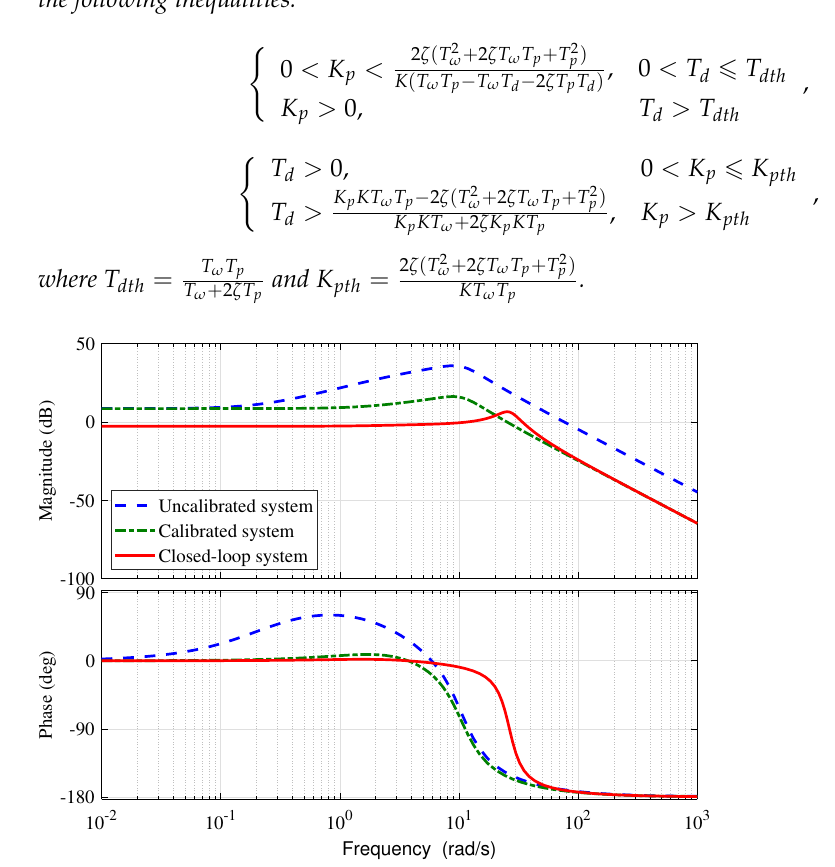
Figure 8. Bode diagram of azimuth